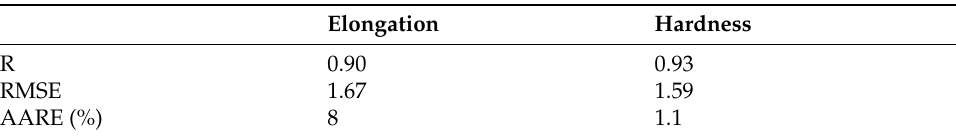
Table 7. The R, RMSE, and AARE (%) of experimental and predicted elongation to failure (%) and hardness (HB) using two hidden layers network.